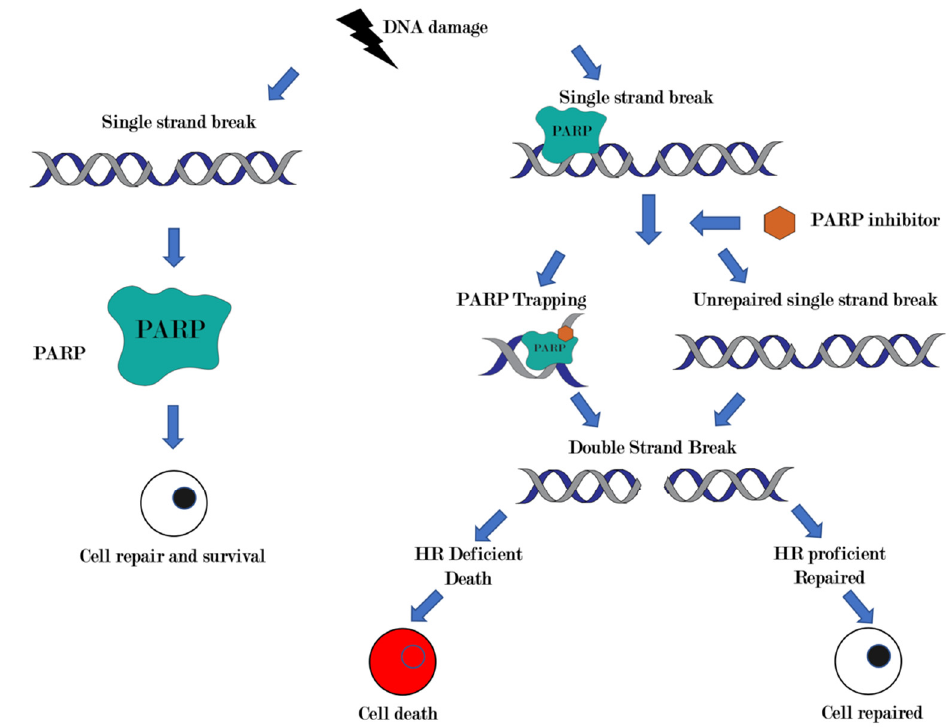
Figure 1. Canonical mechanism of action of PARP inhibitors and synthetic lethality. Poly (ADP- ribose) polymerases are proteins that play a role in DNA damage repair. PARP inhibitors impair base excision repair, which prevents repair of single-strand breaks (SSB). Accumulation of SSB causes replication fork stalling and generates lethal double-stranded breaks (DSB). In homologous recombination (HR) deficient cells, such as BRCA mutated cells, double-stranded breaks cannot be repaired efficiently, thus leading to cell